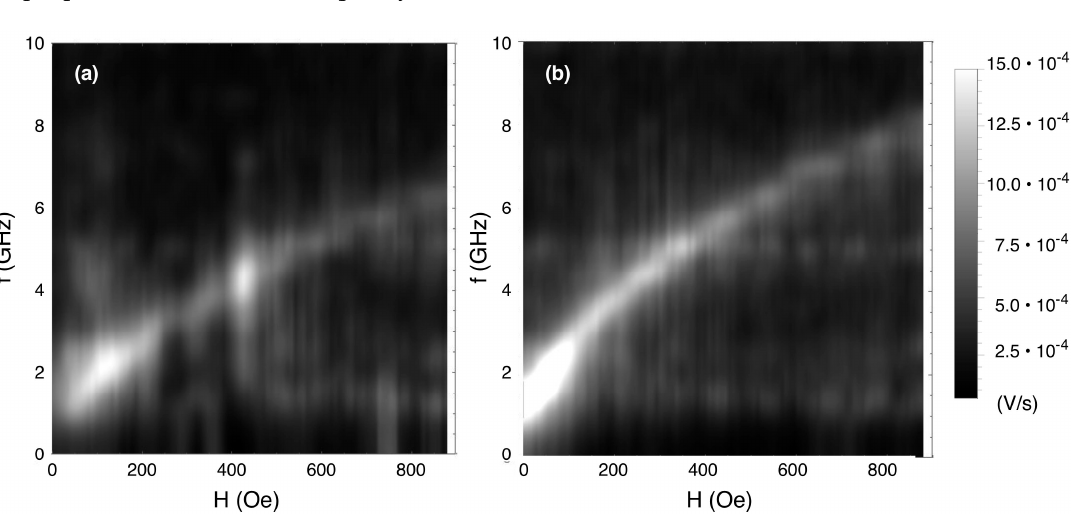
Figure 10. Dispersion measurement in the Ni 80 Fe 20 antidot array ( a ) and in the bi-component nanostructured system ( b ).